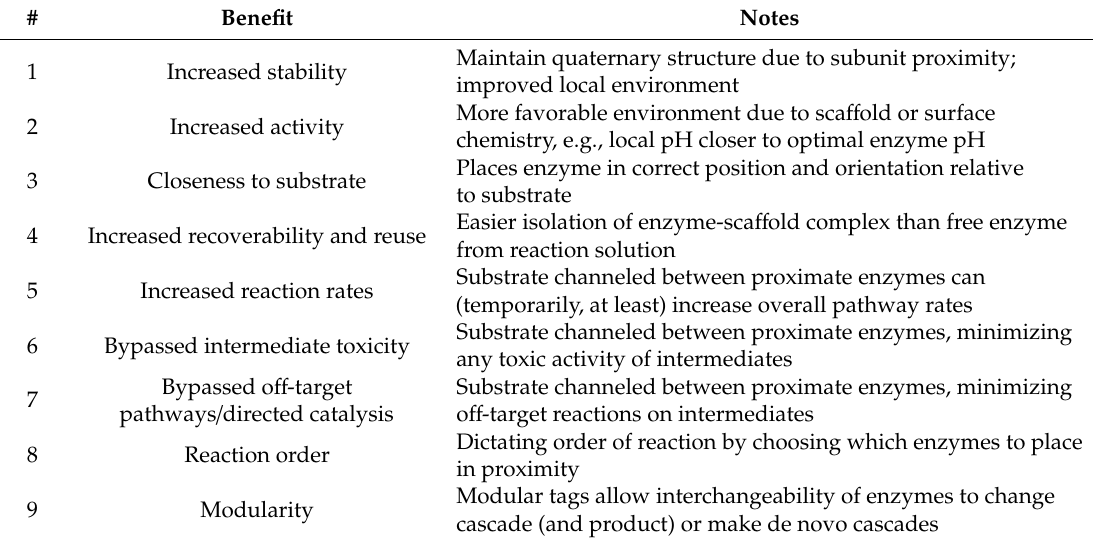
Figure 1. Enzyme immobilization can result in multiple benefits (1–9) [4,10,23–30]. Table 1. Potential Benefits of Enzyme Table 1. Potential Benefits of Enzyme Immobilization